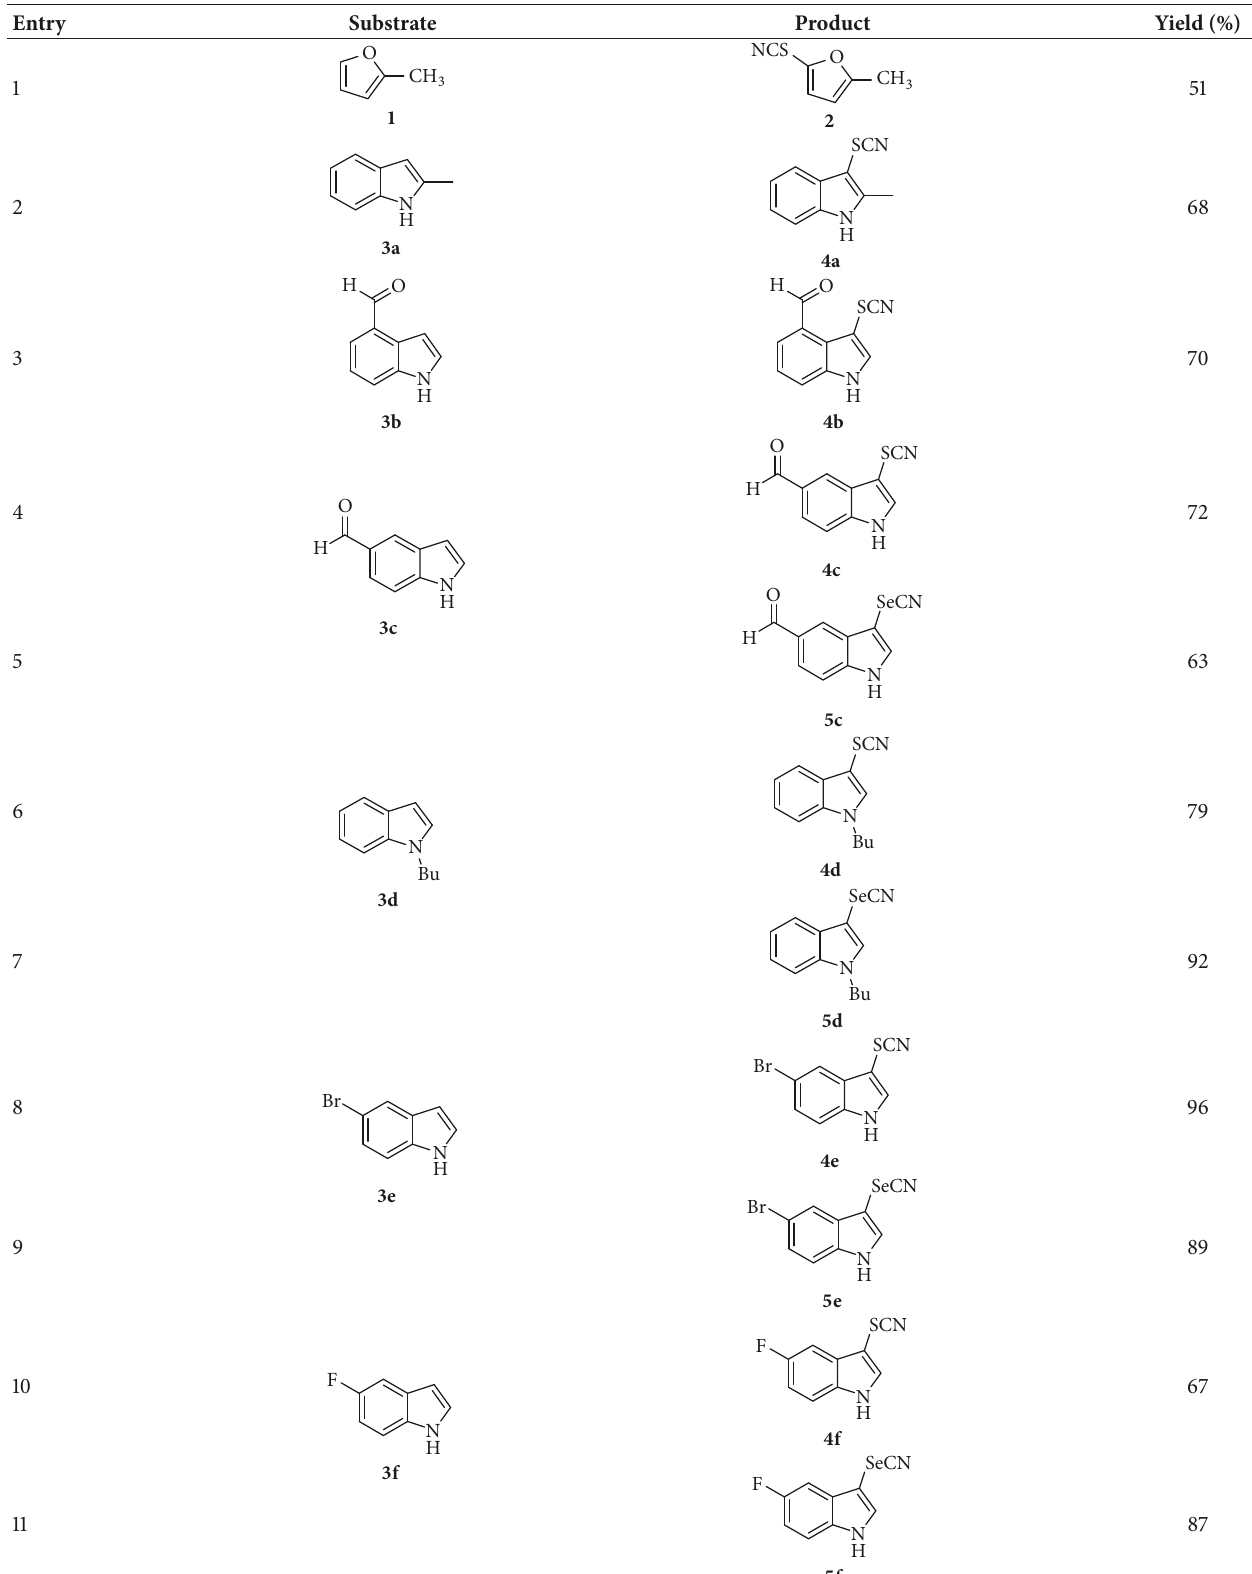
Table 1: Products resulting from thiocyanation and selenocyanation of diverse furano 1 and indole 3 substrates. En t